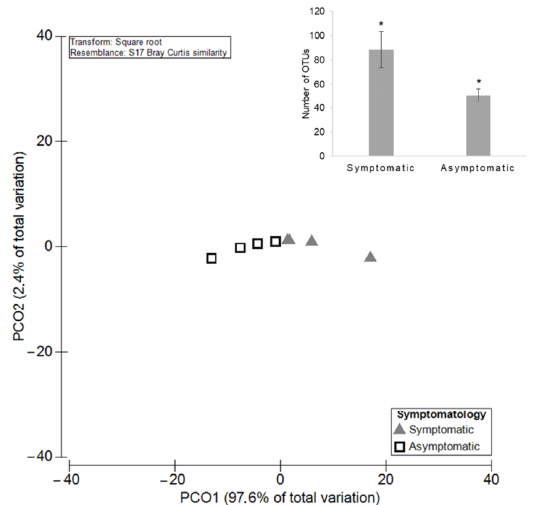
Figure 7. Principal Coordinates Analysis (PCO) based on the diversity of the endophytic fungal communities among GTDs symptomatic and asymptomatic grapevines. The average of the total OTUs number for both groups is shown in bar plot and significant differences ( p < 0.05) are indicated by asterisks.